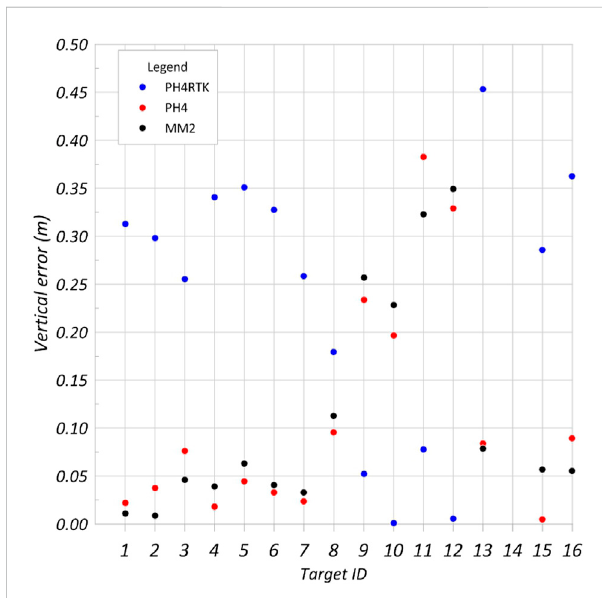
FIGURE 6 Photogrammetric UAS-based vertical error estimated for each underwater target surveyed with the GNSS station.